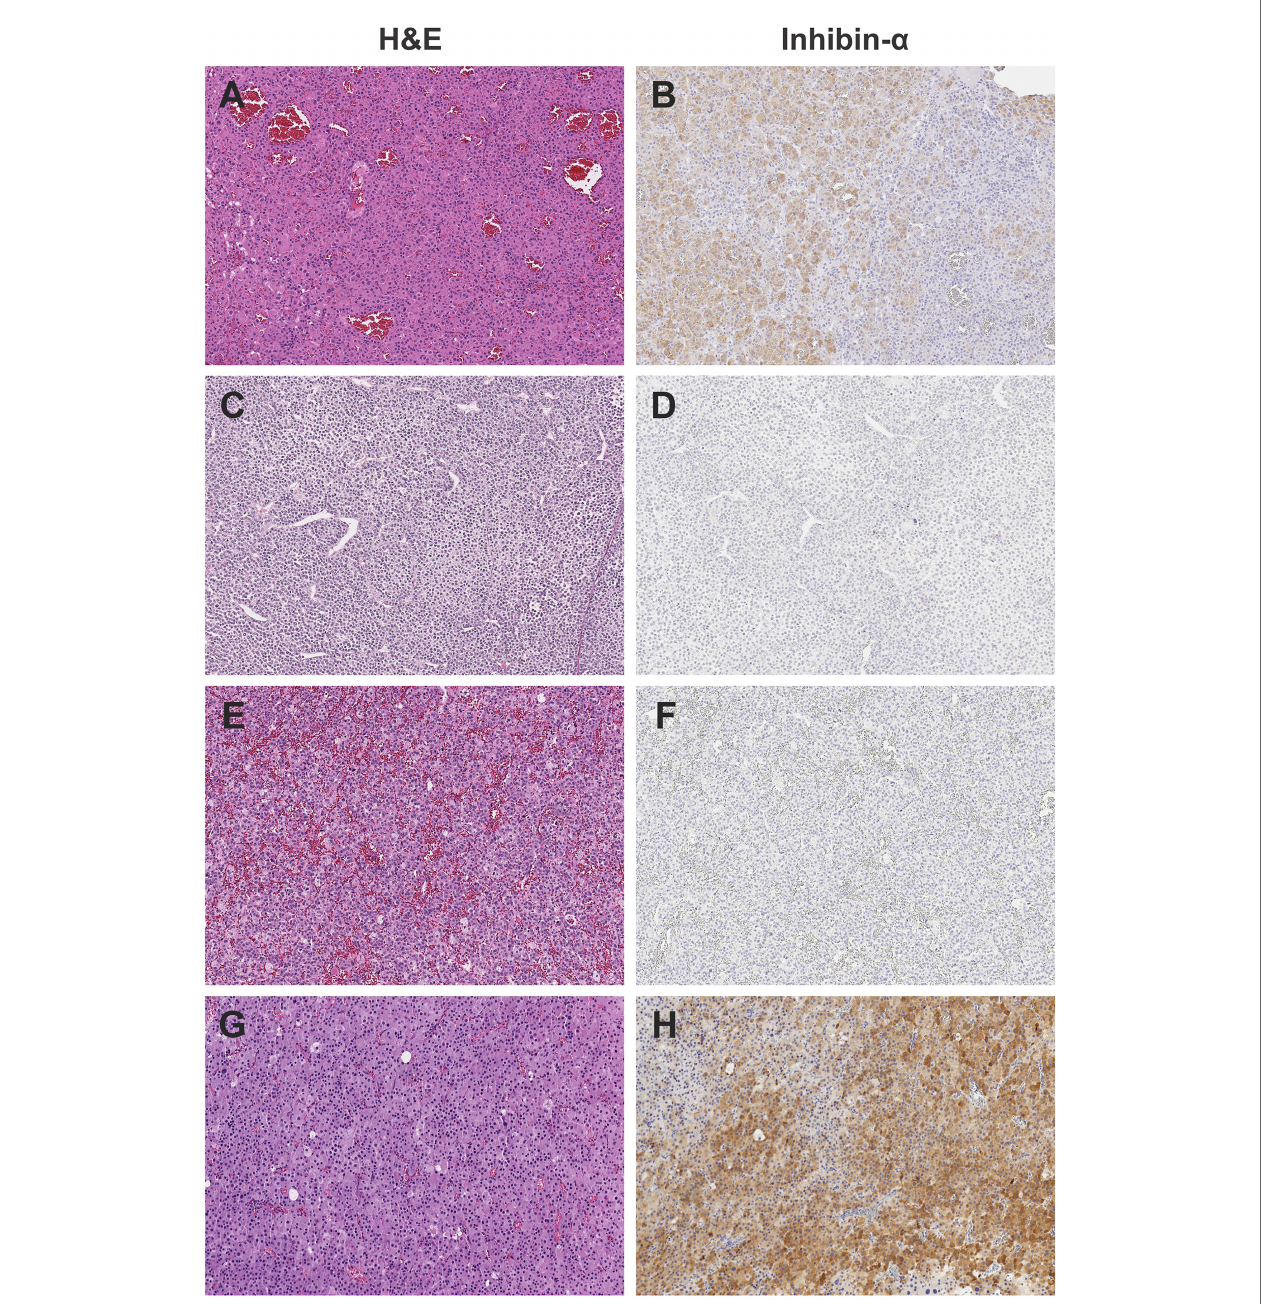
FIGURE 3 | Representative histology of study cases, showing the heterogeneous appearance of adrenocortical tumors by H&E staining and weak to absent inhibin staining. All images photographed at 10x magni fi cation using Leica Biosystems Aperio ImageScope. (A) H&E, (B) Inhibin, positive in subset of cells of Case #1; Adrenocortical adenoma. (C) H&E, (D) Inhibin, negative of case #3; Adrenocortical carcinoma. (E) H&E, (F) Inhibin, negative of Case #6; Adrenocortical tumor of uncertain malignant potential. (G) H&E, (H) Inhibin positive, patchy, adrenocortical